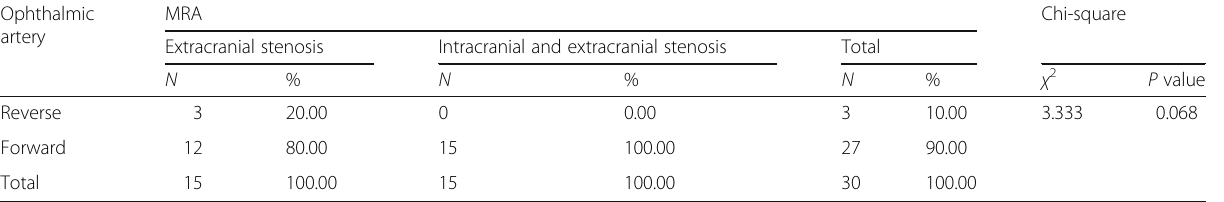
Table 2 Difference in ophthalmic artery flow in both groups Ophthalmic MRA Chi-square artery